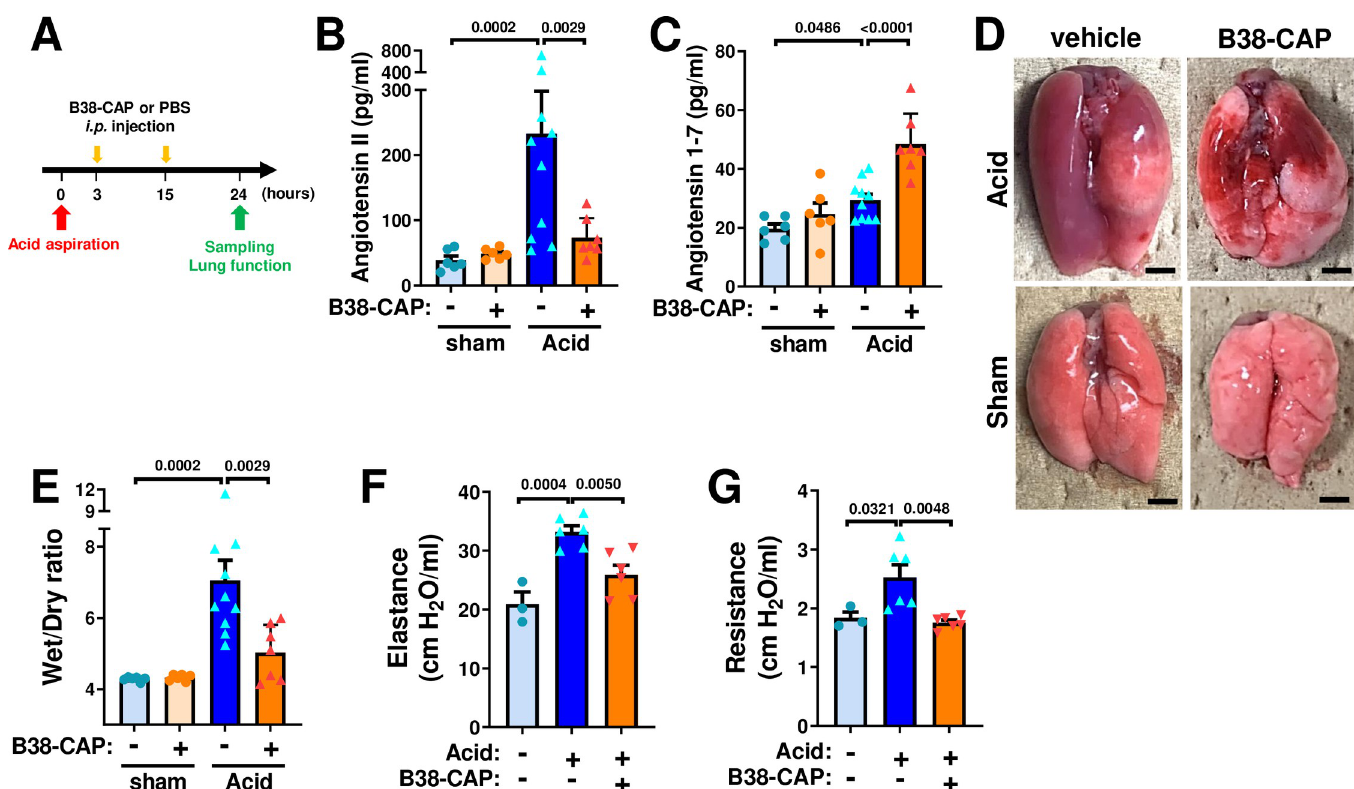
Fig 5. B38-CAP mitigates acid aspiration-induced lung injury. A , Experimental protocol. Mice were intra-tracheally instilled with acid (0.02M HCl, 50 μ l per body) and were injected with B38-CAP (2 mg/kg i . p .). B , Plasma Ang II measurements. C , Ang 1–7 levels in the plasma. D , Representative photograph of mouse lungs. Bars indicate 2 mm. E , Wet to dry weight ratios of lungs. sham + vehicle (n = 6), sham + B38- CAP (n = 6), Acid + vehicle (n = 10) and Acid + B38-CAP (n = 7) ( B-E ). F - G , Lung function measurements at 24 hours after acid instillation. Measurements of elastance ( F ) and resistance ( G ) are shown with sham + vehicle (n = 3), Acid + vehicle (n = 6) and Acid + B38-CAP (n = 6). All values are means ± SEM. One-way ANOVA with Sidak’s multiple-comparisons test. Numbers above square brackets show significant P-